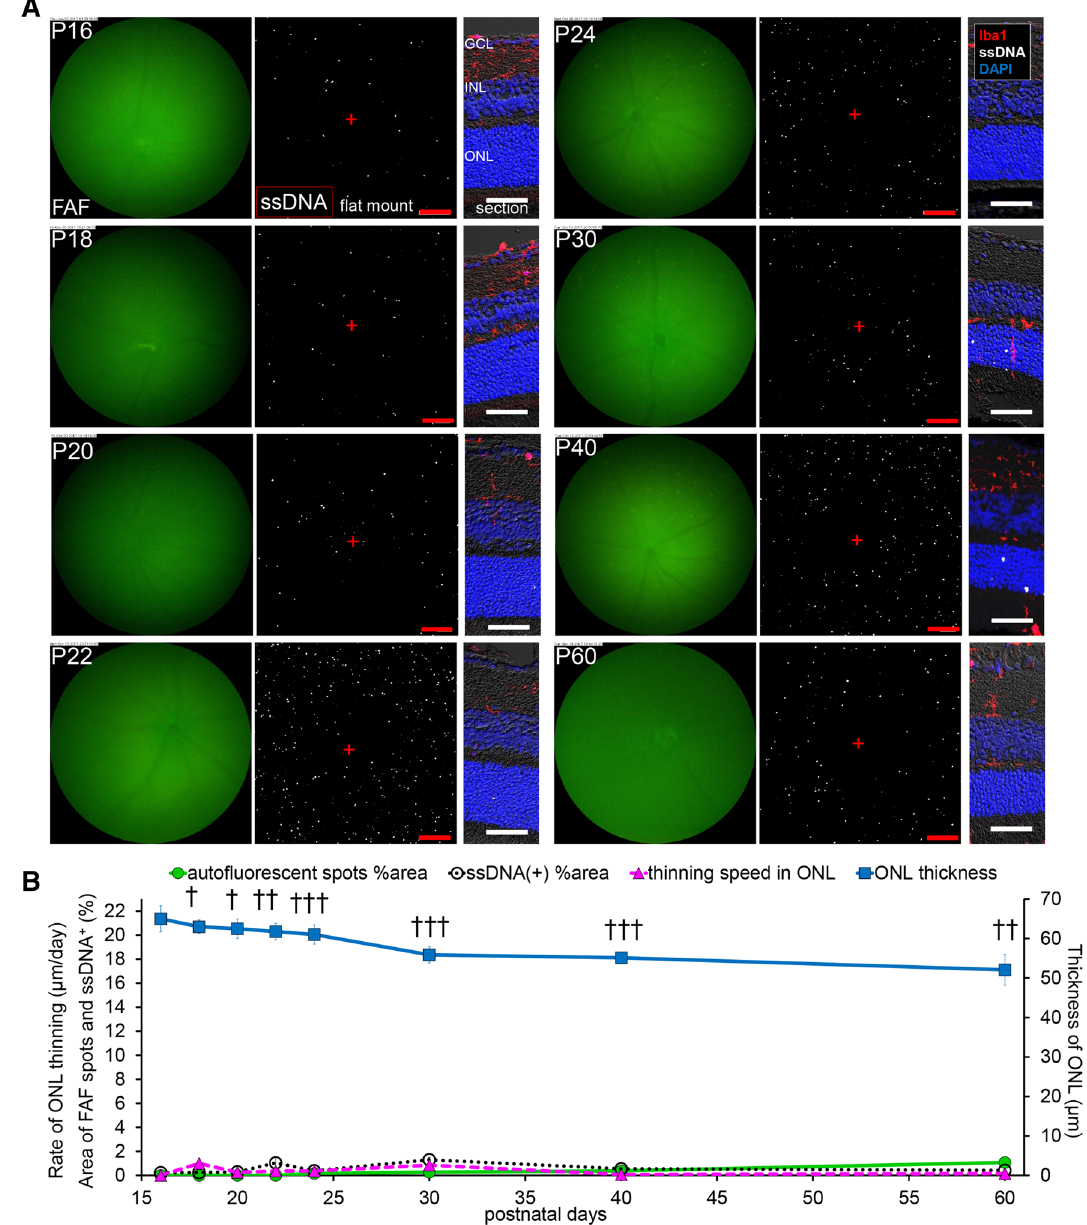
Figure 4. Relationship in fundus autofluorescent spots, apoptosis of photoreceptors and retinal ONL thickness in the central retina of rd10 raised in dark. ( A ) Pictures show the time course change from P16 to P60, in the central retina of rd10 mice raised in dark. Left pictures are in vivo FAF imaging with a retinal imaging microscope. Middle pictures show the confocal images of extracted flat-mounted retina at the ONL level, labeled with ssDNA (white). Scale bars, 100 μm, “ + ” show the center of the optic nerve head. Right pictures show the retinal section labeled with DAPI (blue), ssDNA (white) and Iba1 (red). Scale bars, 50 μm. ( B ) The graphs show the quantification of the FAF spot area % (green line), the ssDNA + area % (black line), the thickness of the ONL (blue line) and the thinning rate of the ONL (magenta line). The markers of the graph show mean and SD (n = 4). († p < 0.005, †† p < 0.00005, ††† p < 0.00000005, t test in comparison to the central retina raised under regular light cycle). Thinning of ONL was significantly suppressed compared to the group raised under regular light cycle. The appearance of FAF spots and ssDNA + apoptotic cells were also suppressed in dark-raised